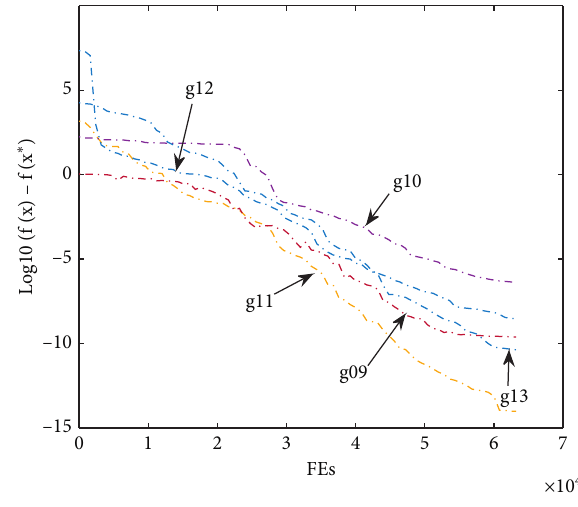
Figure 8: Convergence graph for g09–g13. Table 4: Statistical features of the results obtained by various versions of